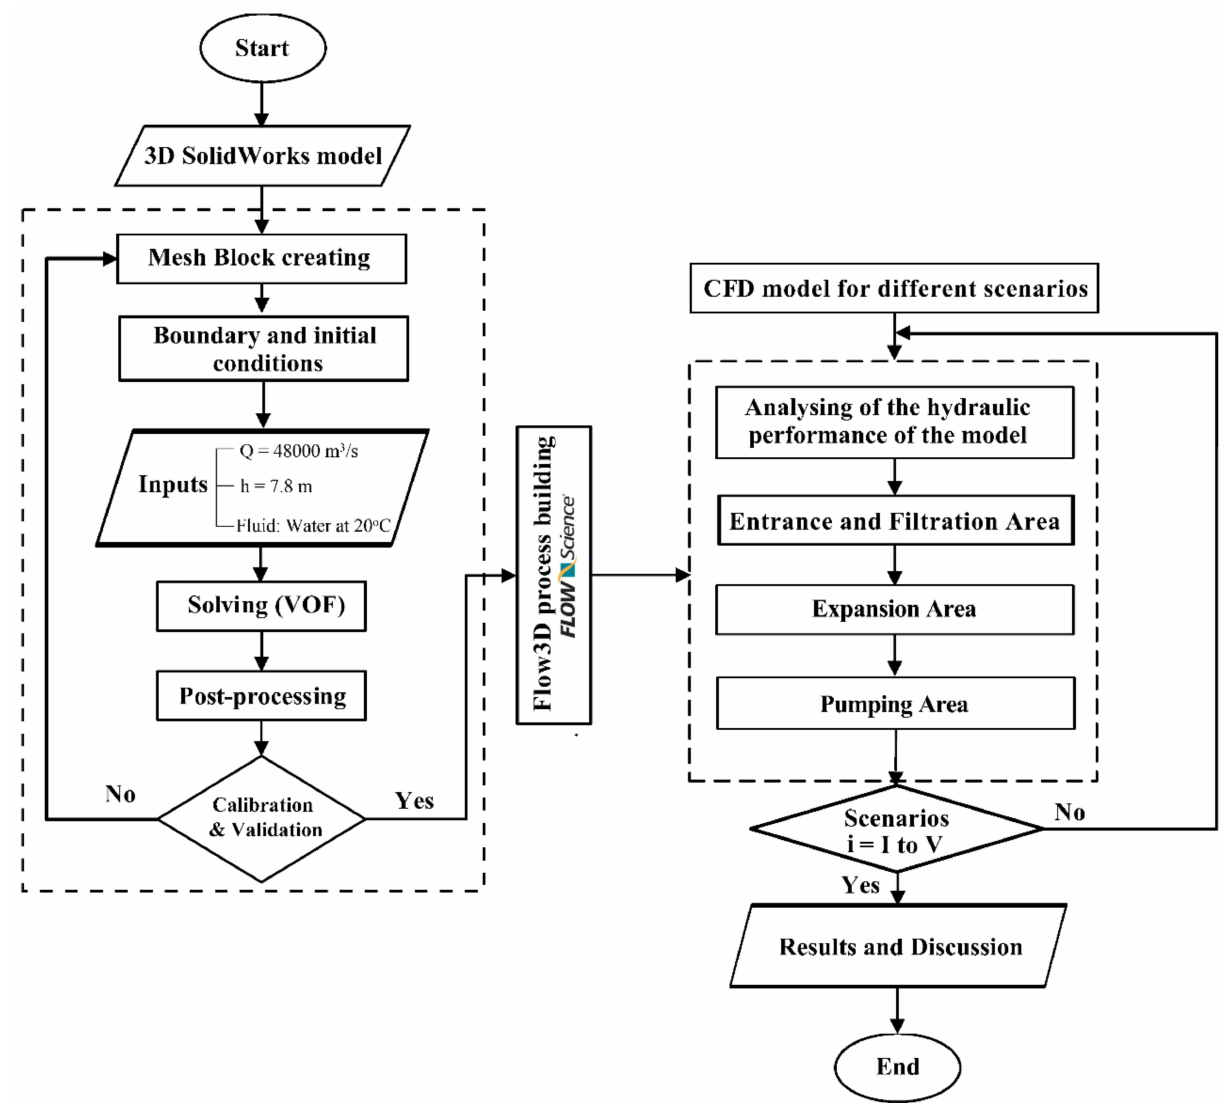
Figure 2. Proposed flow chart for simulation of the seawater intake